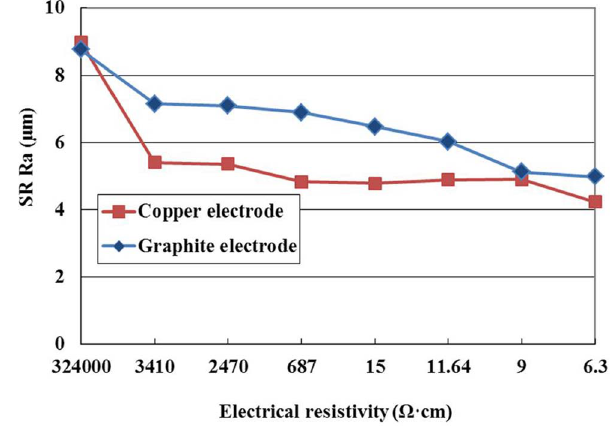
Figure 14. Effect of the electrode material on SR.